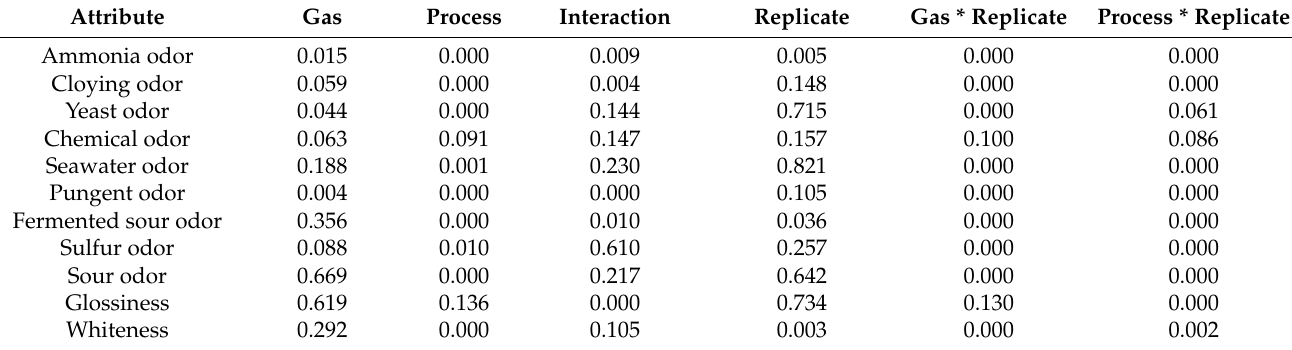
Table A5. ANOVA of sensory descriptive analysis on odors for packaging concepts in storage experiment without industrial samples. Mixed model with effect of assessor, gas, process (freezing/thawing), replicate and two-way interactions. Assessor and interactions with assessors are random effects, other fixed. The "*" is showing the